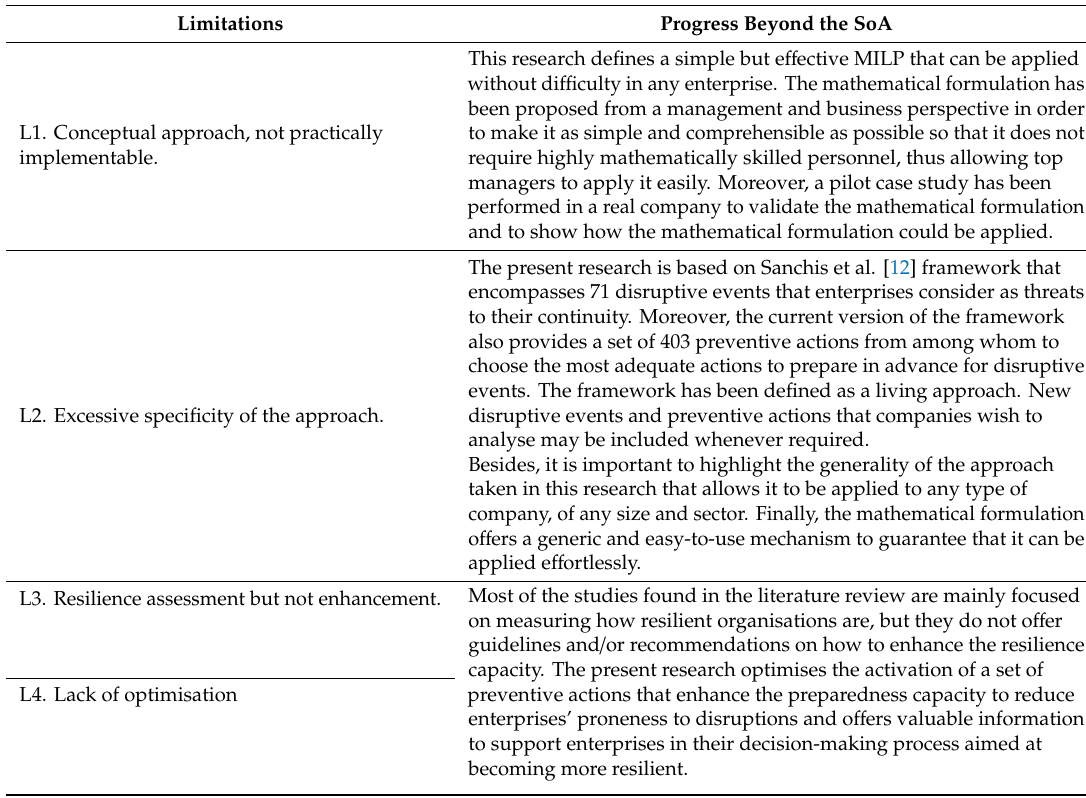
Table 2. Advances beyond the state of the art